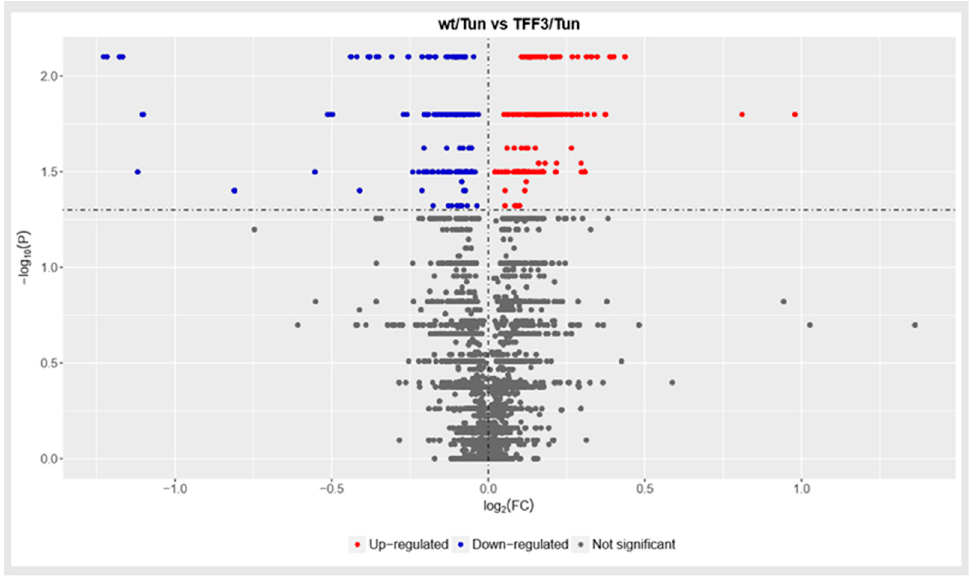
Figure 6. Volcano plot, plotting significance ( − log(P)) on the y-axis, versus fold change (log2FC) on the x -axis. the x